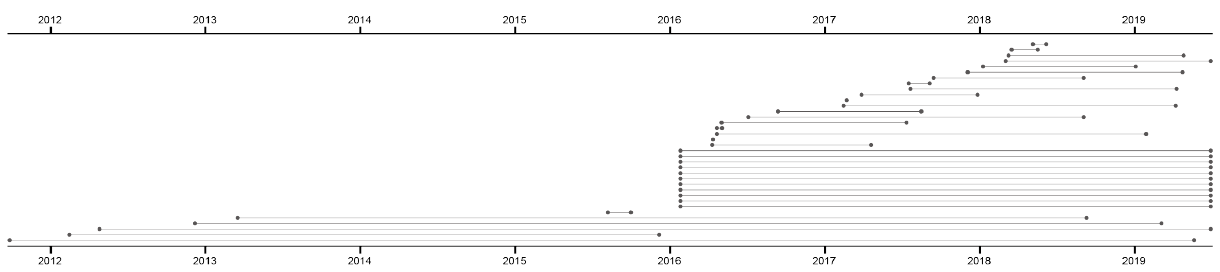
Figure 1. Overview of timespan between release date and recent update date of each museum guide application (Android) from 2011 to date. Only one dot means no update.